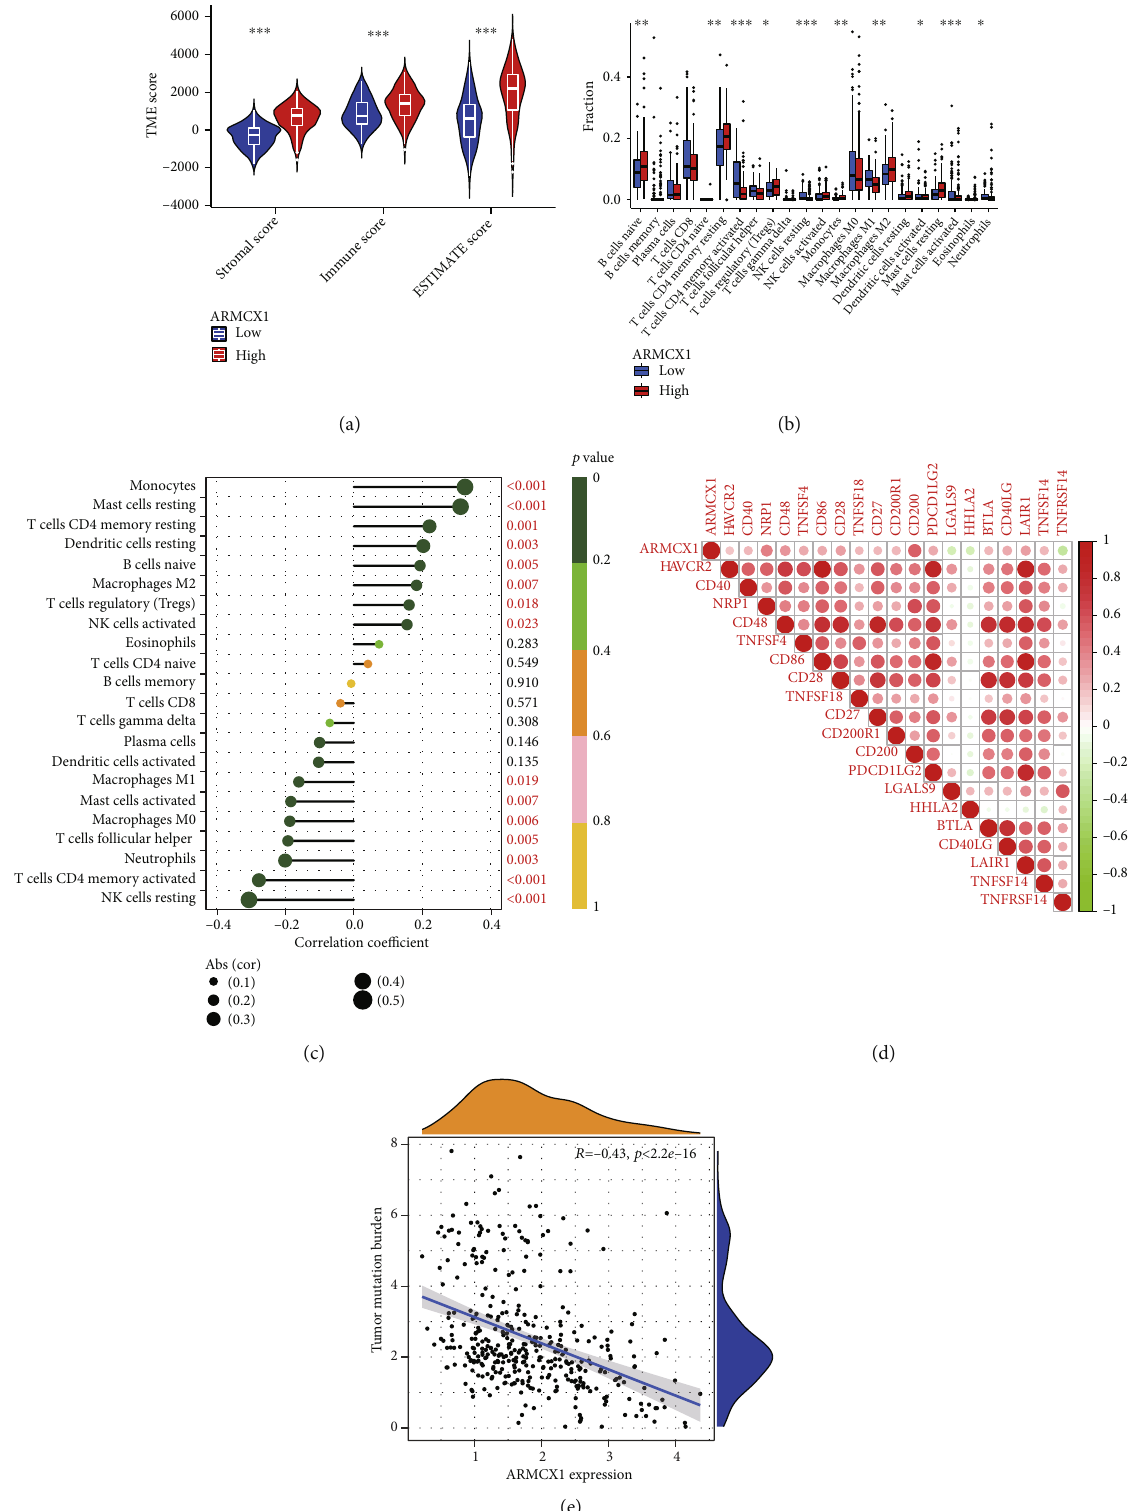
Figure 4: Comparison of tumor microenvironments between GC patients with high and low ARMCX1 expression. (a) Di ff erence in tumor microenvironment score between the high and low ARMCX1 groups. (b) Immune in fi ltration by 22 immune cell types in patients with GC exhibiting high and low ARMCX1 expression. (c) Correlation between ARMCX1 gene expression and immune cell in fi ltration. (d) Correlation of ARMCX1 expression with immune checkpoint gene expression. Red and green represent positive and negative correlations, respectively. (e) Correlations between ARMCX1 gene and tumor mutation burden ( p < 2 : 2e − 16 , R = − 0 : 43